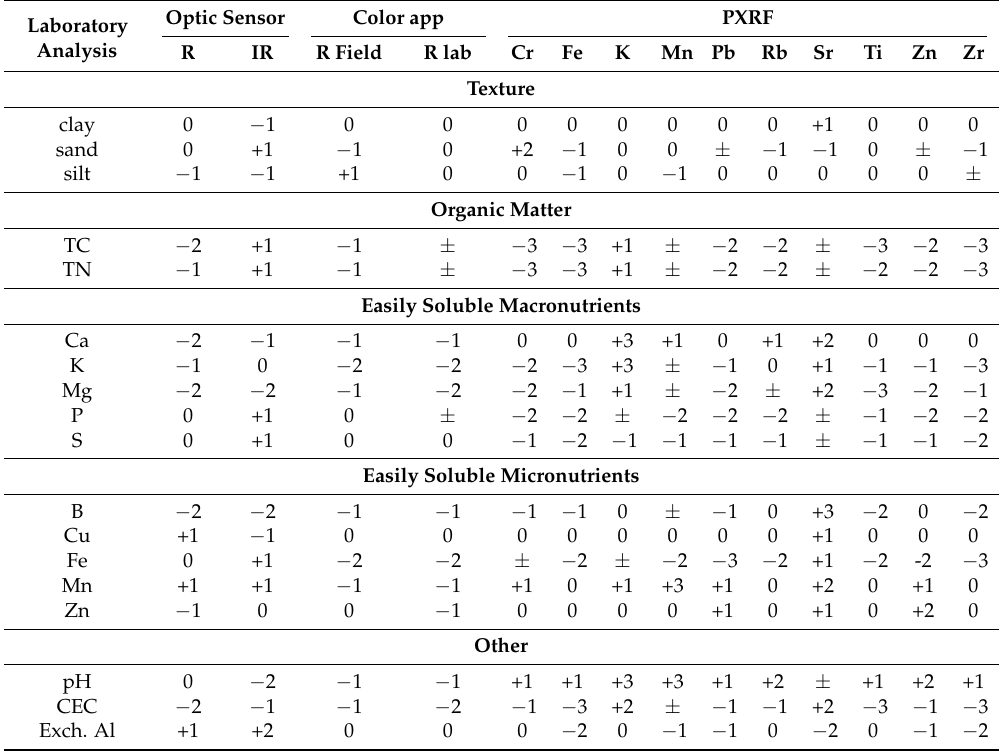
Table 3. Pairwise correlations between sensor variables and lab variables. Sensor variables for which less than 70% of the observations were above the detection limit at any of the sites were omitted from this analysis. The correlations were tested site-by-site and judged at the confidence level p < 0.05. − = one or more sites with a significant negative correlation but no site with a significant positive correlation; + = one or more sites with a significant positive correlation but no site with a significant negative correlation; ± = at least one site with a significant negative correlation and at least one site with a significant positive correlation; the numbers indicate the number of sites with significant correlations. TC = total carbon; TN = total nitrogen; and CEC = cation exchange capacity. The red reflectance (R) value of the optic mapper was a 20 nm band centered on 660 nm and that the R value of the app was the broad red band of the mobile phone camera. Exch. Al = exchangeable